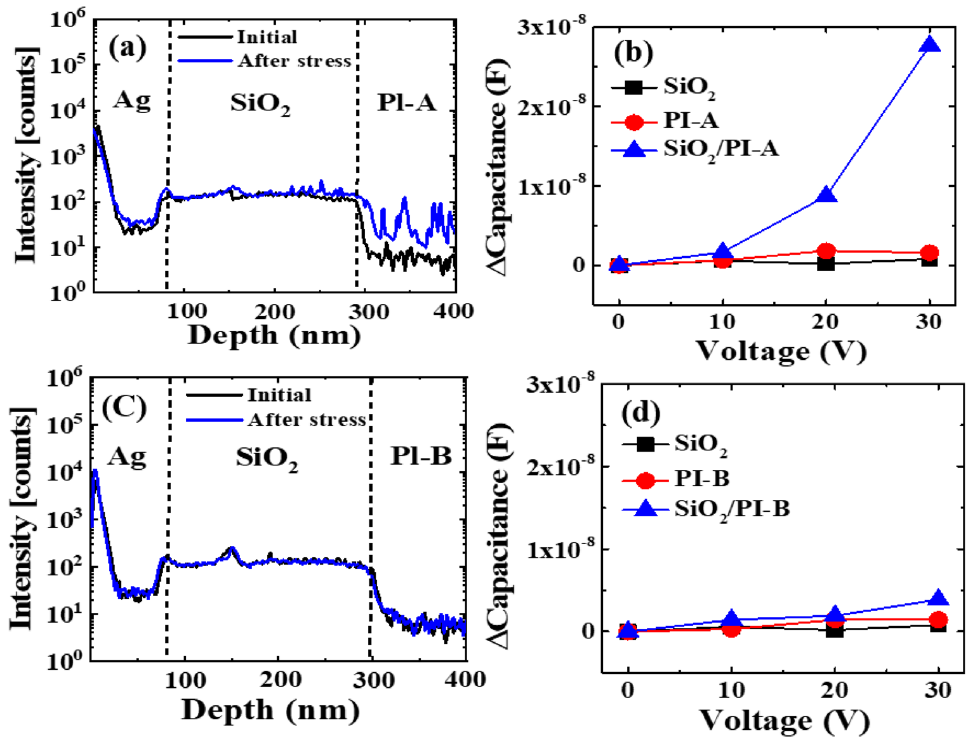
Figure 7. SIMS characterization of Ag/SiO 2 /PI/Ag capacitor focused on fluorine profile at the interface; ( a , b ) with PI-A type and ( c , d ) with PI-B type. Note that PI-A is less crosslink density than